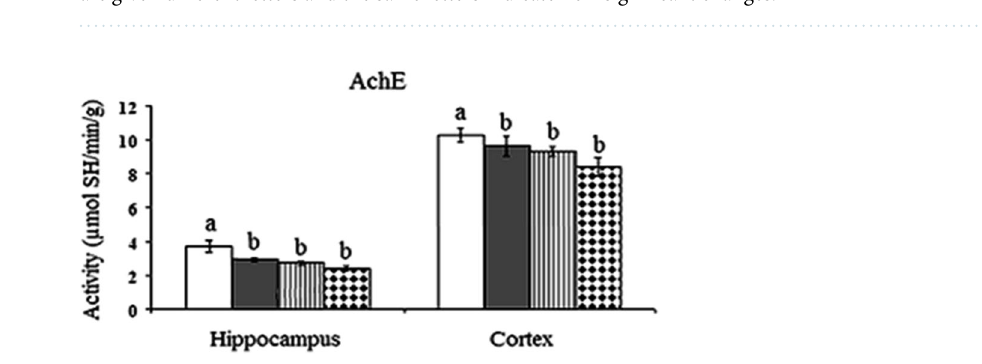
Figure 8. Effect of different doses of green synthesized silver nanoparticles (AgNPs) (0.5 mg/kg, 5 mg/kg, and 10 mg/kg) on the levels of lipid peroxidation (MDA), reduced glutathione (GSH), nitric oxide level (NO) in the hippocampus and cortex of rat brain. Control, Rats treated with AgNPs (0.5 mg/kg), Rats treated with AgNPs (5 mg/kg), Rats treated with AgNPs (10 mg/kg). Statistically significant means (p-value < 0.05) are given different letters and the same letters indicate non-significant changes.